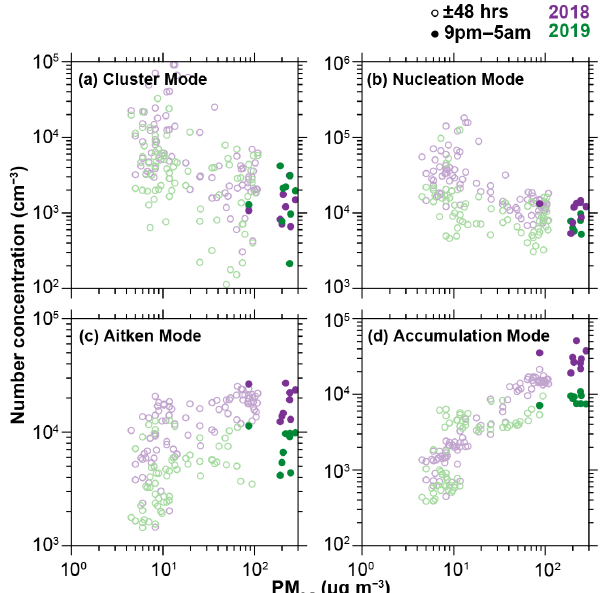
Figure 6. Aerosol particle number concentrations in cluster, nu- cleation, Aitken, and accumulation modes as a function of PM 2 . 5 mass concentration in 2018 (purple) and 2019 (green), separated from 21:00 through 05:00 the night of the CNY (filled circles), and those of CNY ± 48h (open circles). The data are from BUCT-AHL.